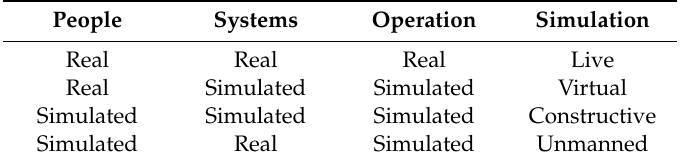
Table 1. Categorizing simulations based on the interaction of people and systems. People Systems Operation Simulation Real Real Real Live Real Simulated Simulated Virtual Simulated Simulated Simulated Constructive Simulated Real Simulated